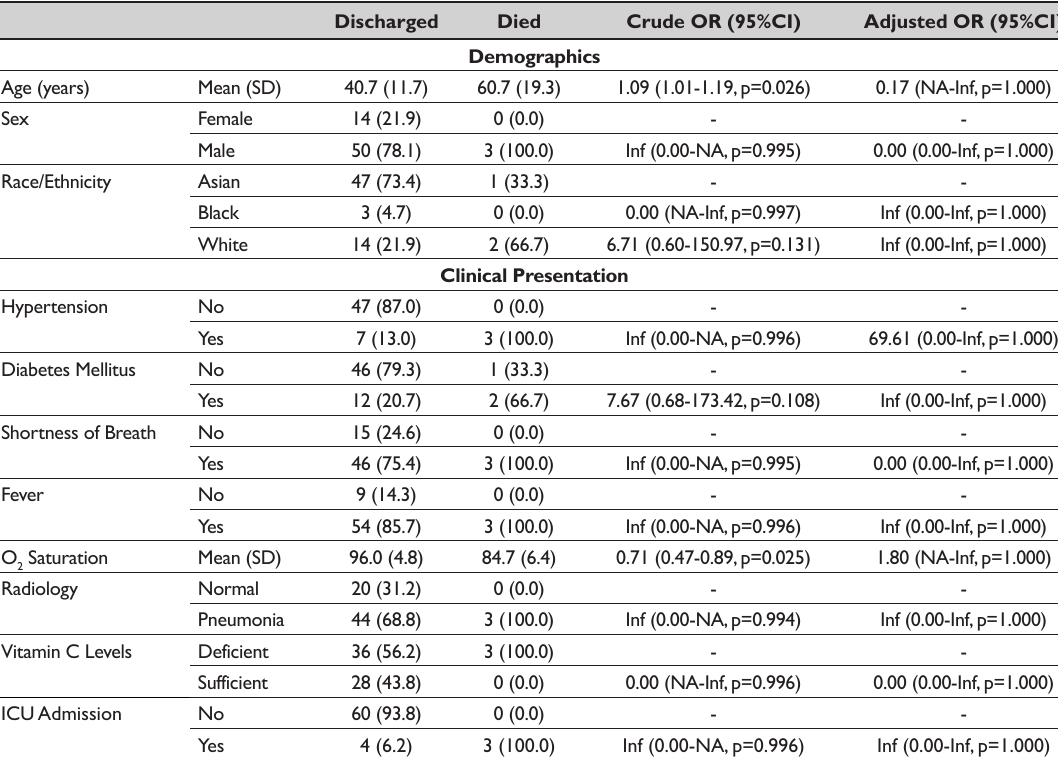
Table 4: Predictors for COVID-19 mortality using univariate and multivariate logistic regression analysis